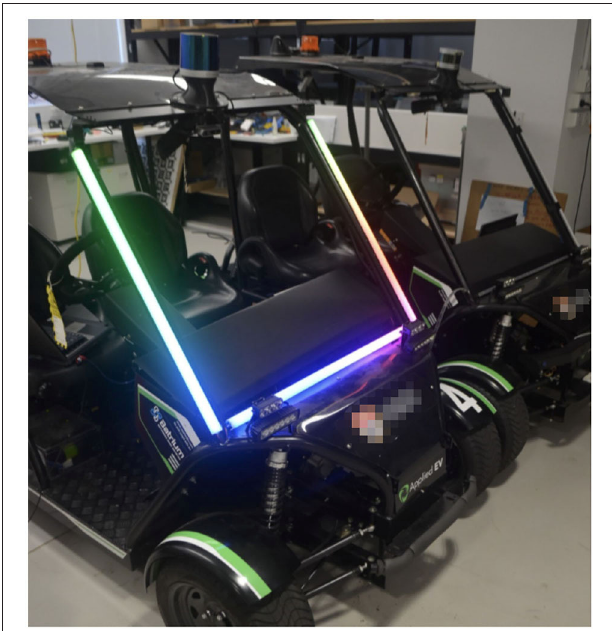
FIGURE 1 | Passenger transport pod with “U”-shaped low-res lighting